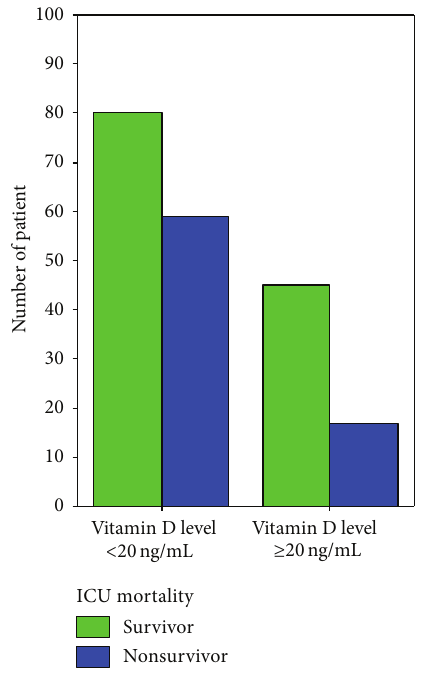
Figure 8: Applying invasive mechanical ventilation on admission in vitamin D insufficient and sufficient patients (𝑃 = 0.012) .